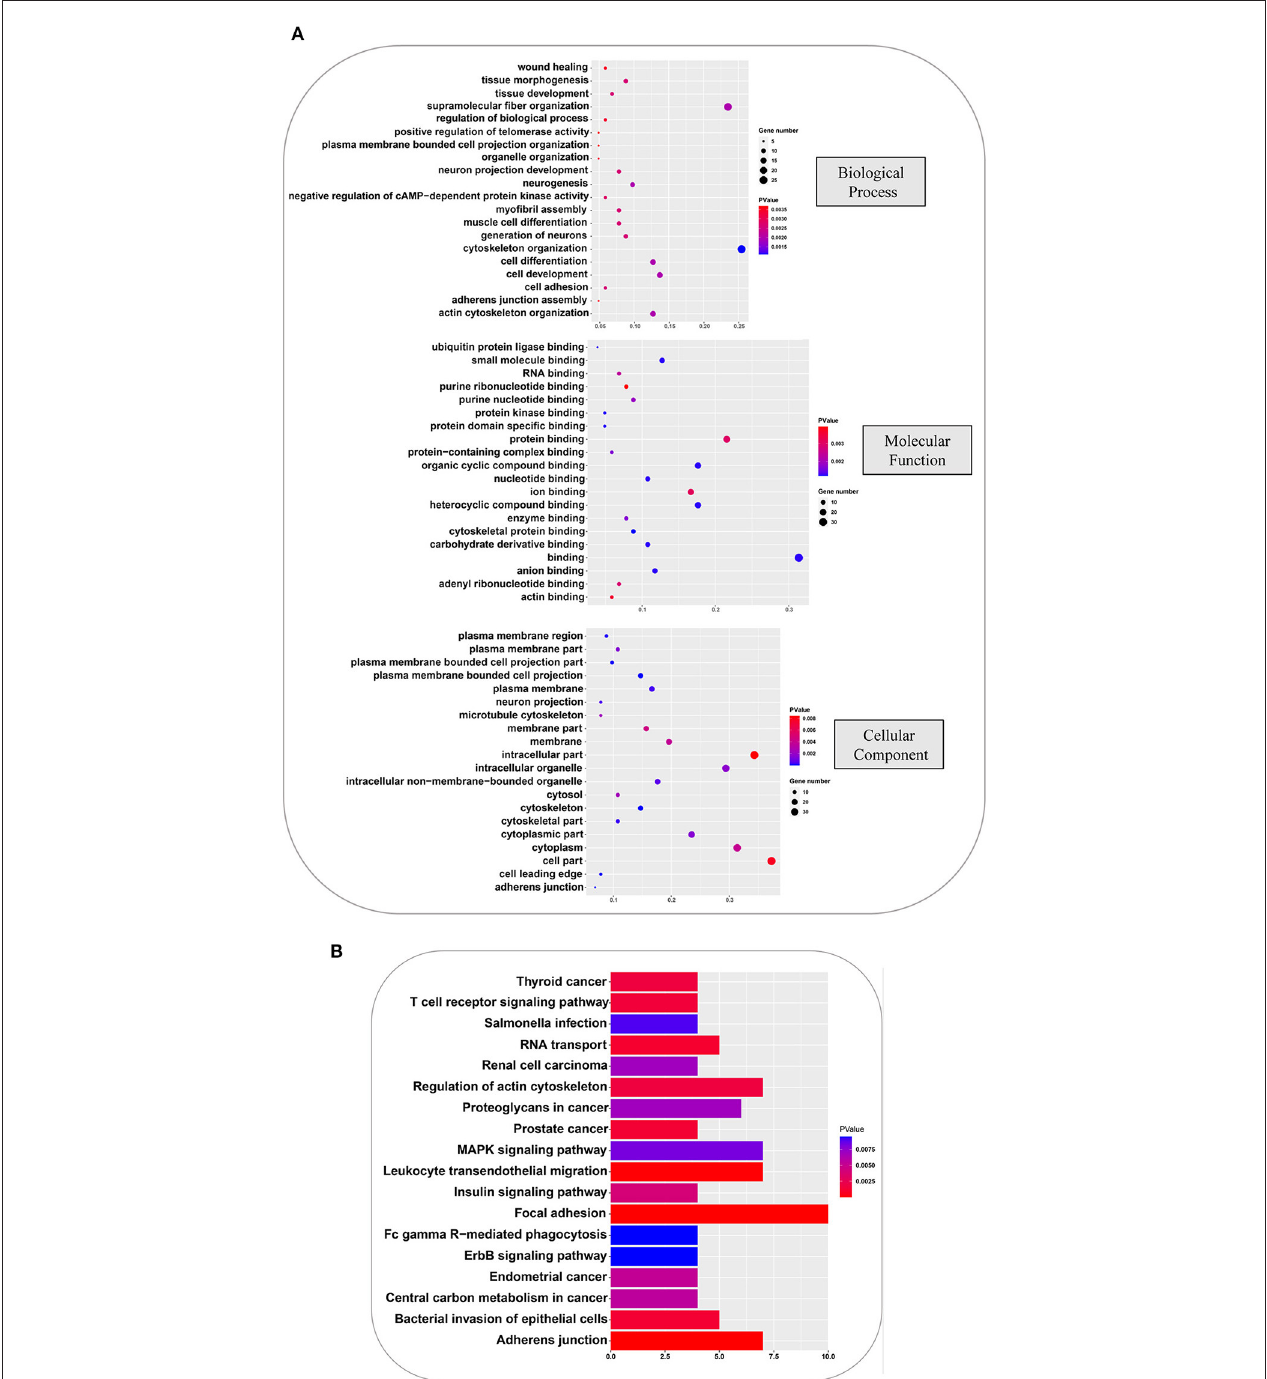
FIGURE 5 | GO and KEGG analyses, based on the phosphorylated proteins that were positively associated with the amino acid signals. (A) GO analysis of phosphorylated proteins positively associated with all amino acids, including: biological processes, such as cytoskeleton organization, supramolecular fiber organization, cell development, cell differentiation, and actin cytoskeleton organization; molecular function, such as binding, protein binding, organic cyclic compound binding, heterocyclic compound binding, and ion binding; and cellular component, such as cell part, intracellular part, cytoplasm, intracellular organelle, and cytoplasmic part. (B) KEGG pathway analysis of phosphorylated proteins that were positively associated with all amino acids, indicating that focal adhesion, MAPK signaling pathway, adherent junction, leukocyte transendothelial migration, and regulation of actin cytoskeleton were principal terms.